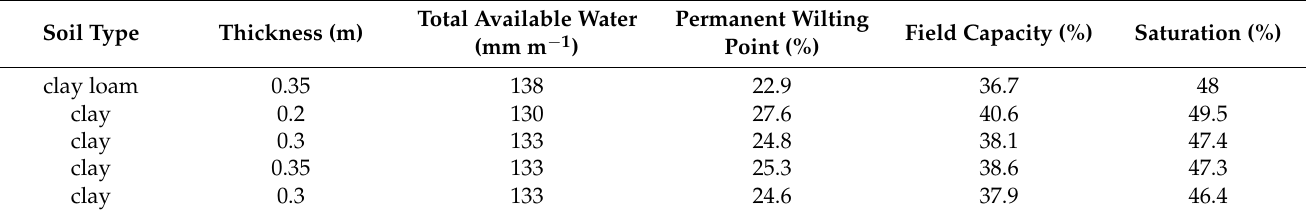
Table 1. Soil characteristics of the experimental site.